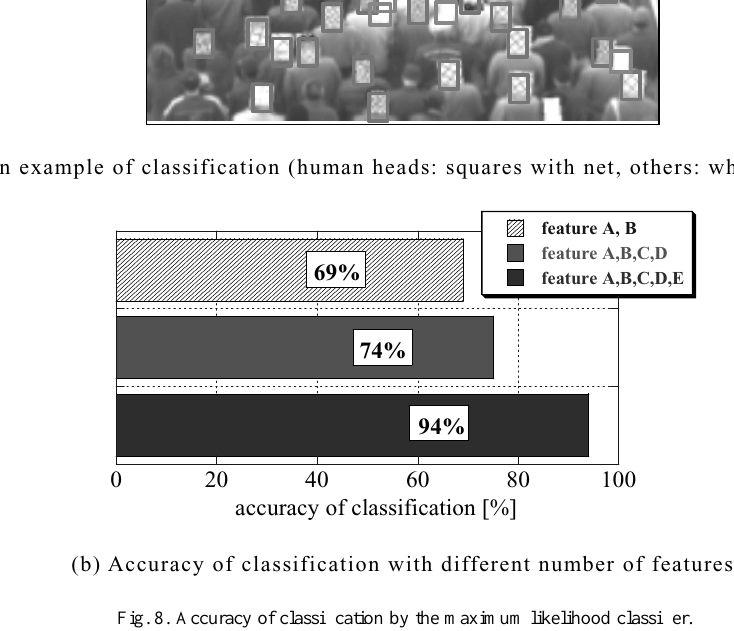
Fig. 8. Accuracy of classification by the maximum likelihood